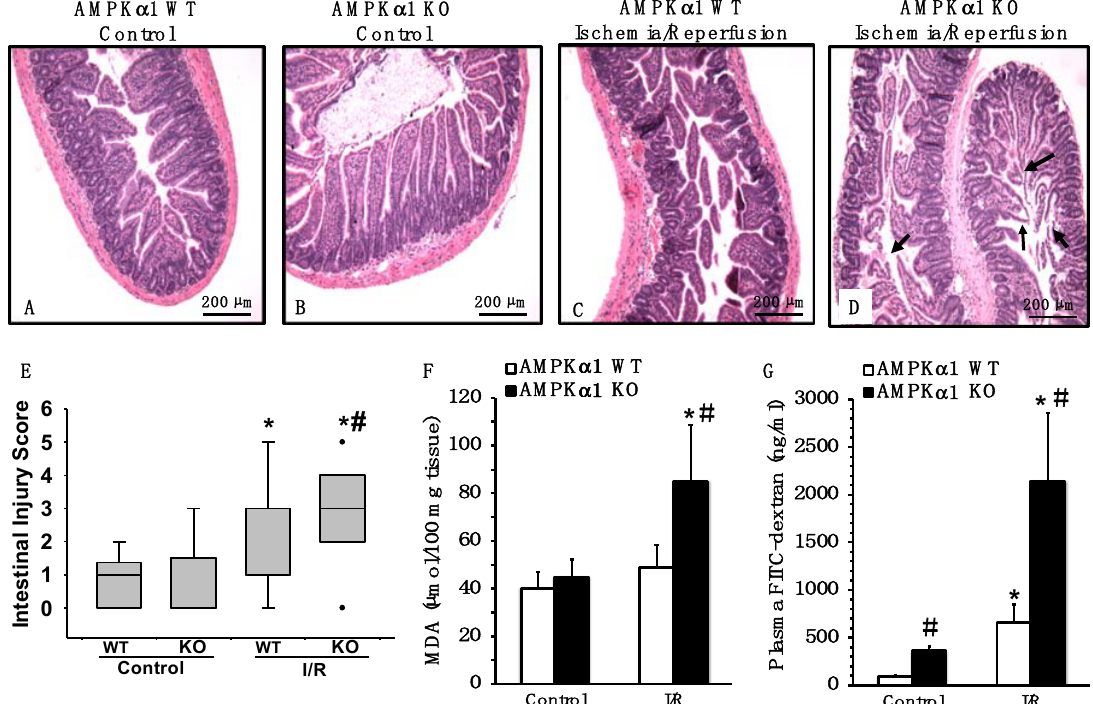
Figure 2. Effect of genetic deficiency of AMPK α 1 on gut injury. ( A – D ) Representative histology photomicrographs of ileum sections of AMPK α 1 WT and KO mice at basal control conditions and at 4 h after mesenteric ischemia and reperfusion (I/R). ( A ) Normal villi and basement membrane in control WT and ( B ) control KO mice. ( C ) Increased edema and hemorrhage and moderate lifting of the epithelial layer from the lamina propria in WT mice subjected to I/R injury. ( D ) Massive disruption to the villi with mucosal ulceration and lifting of the lamina propria (arrows) in KO mice subjected to I/R injury. Magnification × 40. ( E ) Ileum injury score ( n = 6 mice for each group). Ileum injury was scored from 0 (no damage) to 6 (maximum damage). Box plots represent 25th percentile, median and 75th percentile; error bars define 10th and 90th percentiles; dots define outliers. ( F ) Ileum lipid peroxidation assay by malondialdehyde (MDA). Data represent the mean ± SEM of 10 mice for each group. ( G ) Intestinal permeability measurement by plasma levels of FITC-dextran. Data represent the mean ± SEM of 10 mice for each group; * p < 0.05 versus control mice of the same genotype; # p < 0.05 versus WT group. Scale bar: 200 µ